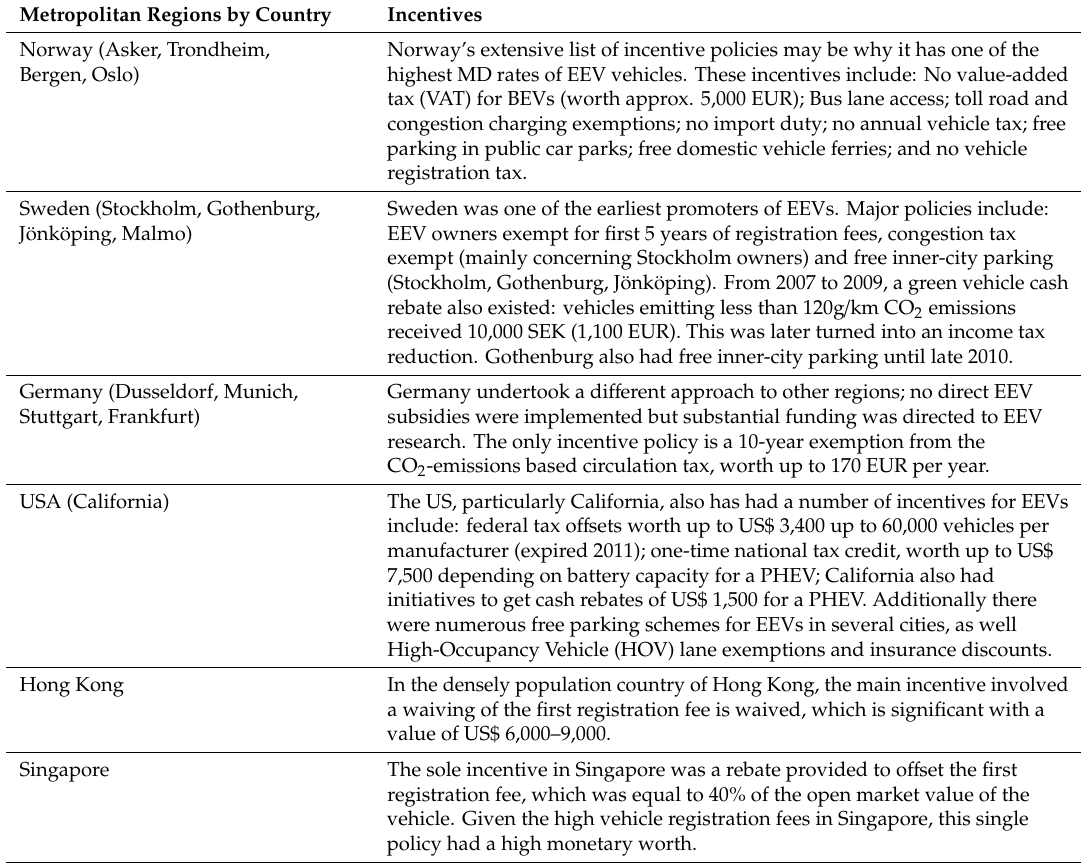
Table 2. Overview of incentive policies active in each metropolitan region, noting that many of these policies also apply to battery electric vehicles, which are not analyzed in this